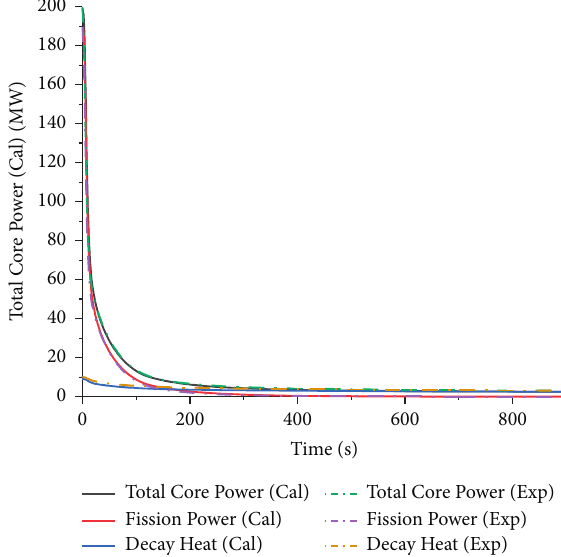
Figure 17: Reactor power of FFTF LOFWOS test #13.